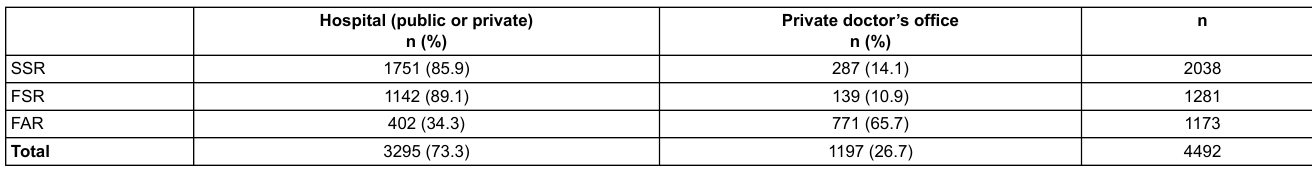
Table 4: Place of VTP chosen (2008–2015).